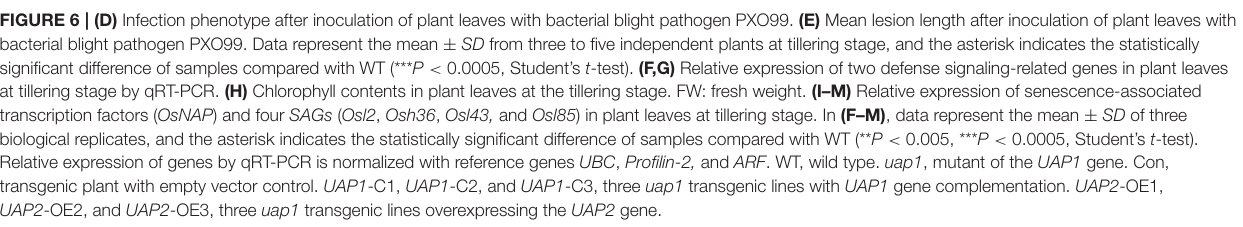
FIGURE 6 | (D) Infection phenotype after inoculation of plant leaves with bacterial blight pathogen PXO99. (E) Mean lesion length after inoculation of plant leaves with bacterial blight pathogen PXO99. Data represent the mean ± SD from three to five independent plants at tillering stage, and the asterisk indicates the statistically significant difference of samples compared with WT (*** P < 0.0005, Student’s t -test). (F,G) Relative expression of two defense signaling-related genes in plant leaves at tillering stage by qRT-PCR. (H) Chlorophyll contents in plant leaves at the tillering stage. FW: fresh weight. (I–M) Relative expression of senescence-associated transcription factors ( OsNAP ) and four SAGs ( Osl2 , Osh36 , Osl43, and Osl85 ) in plant leaves at tillering stage. In (F–M) , data represent the mean ± SD of three biological replicates, and the asterisk indicates the statistically significant difference of samples compared with WT (** P < 0.005, *** P < 0.0005, Student’s t -test). Relative expression of genes by qRT-PCR is normalized with reference genes UBC , Profilin-2, and ARF . WT, wild type. uap1 , mutant of the UAP1 gene. Con, transgenic plant with empty vector control. UAP1 -C1, UAP1 -C2, and UAP1 -C3, three uap1 transgenic lines with UAP1 gene complementation. UAP2 -OE1, UAP2 -OE2, and UAP2 -OE3, three uap1 transgenic lines overexpressing the UAP2